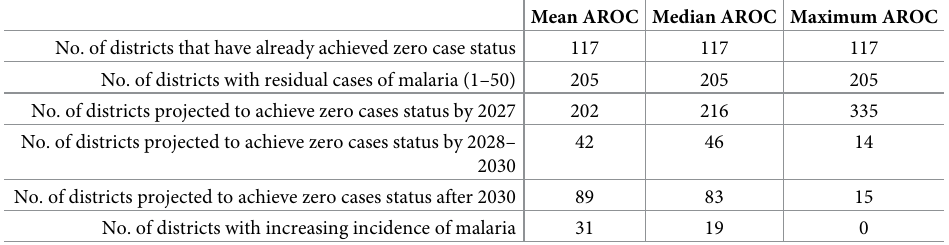
Table 1. Summary of districts projected to achieve/not achieve zero case status using different methods. No. of districts that have already achieved zero case status 117 117